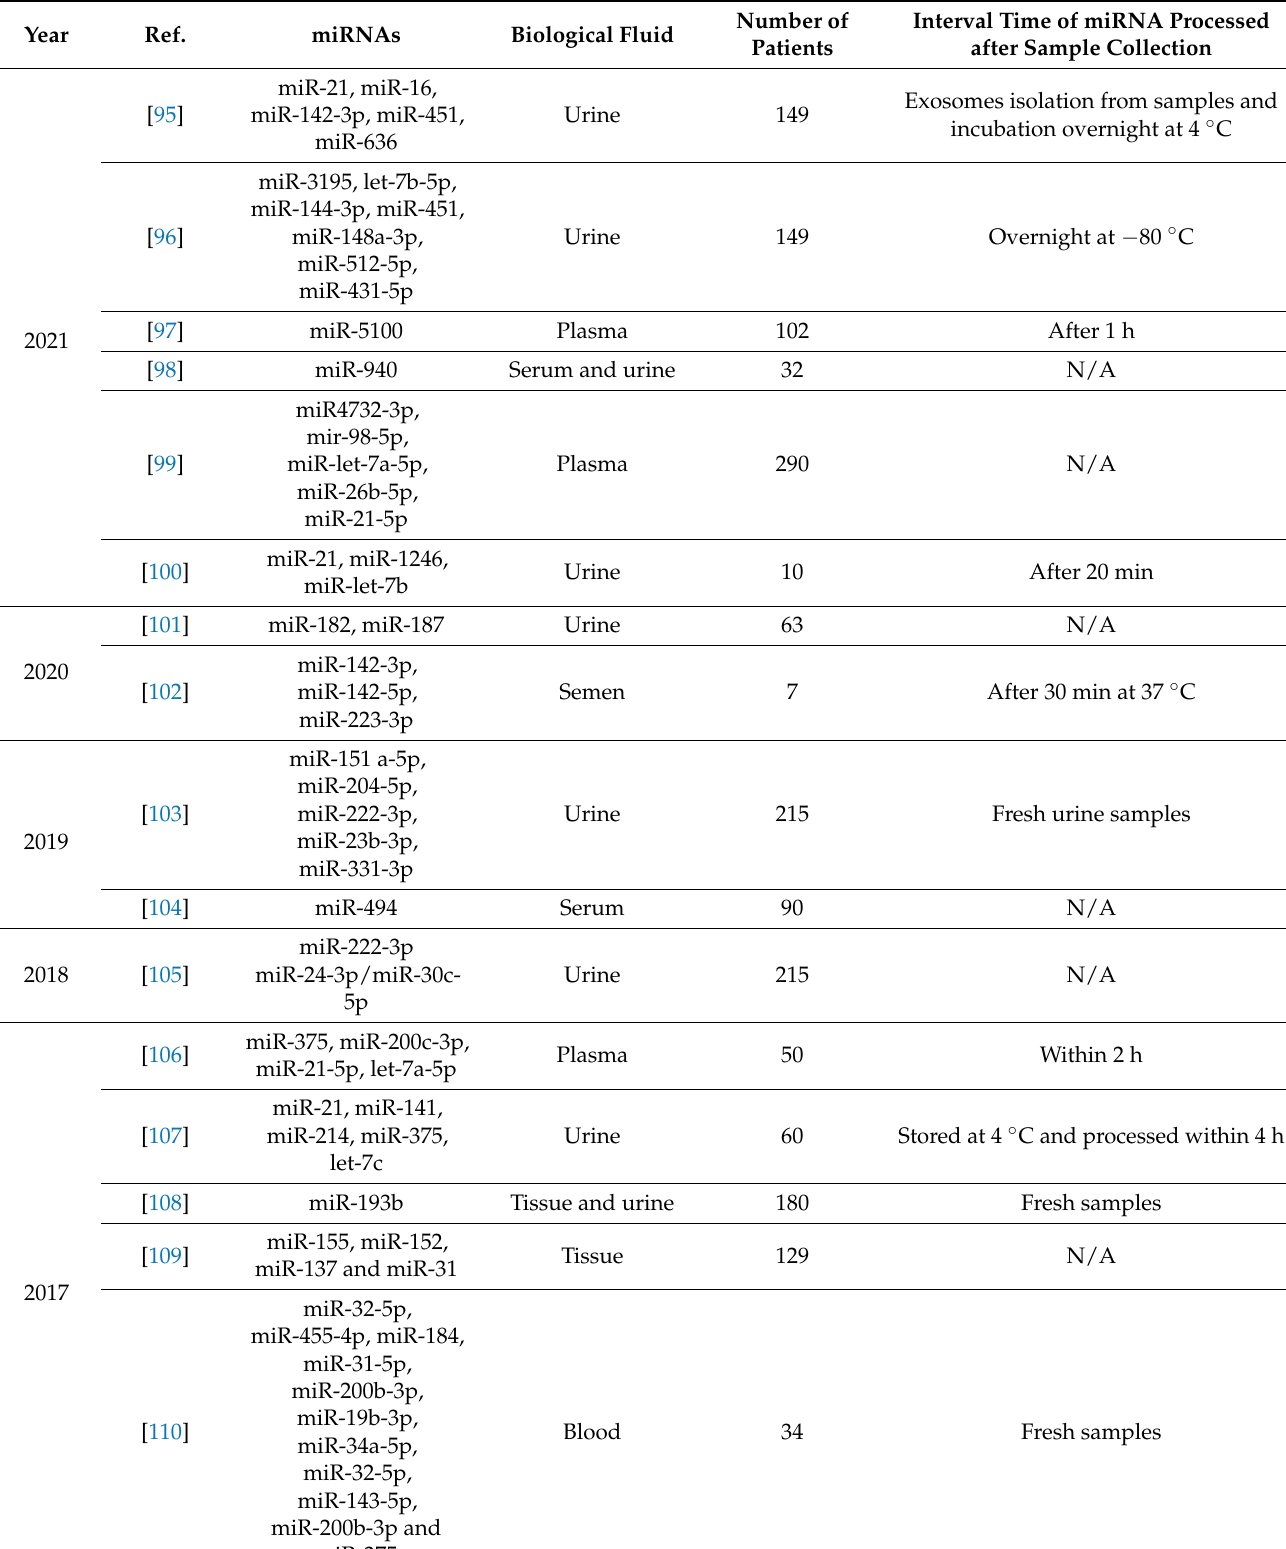
Table 3. List of the most relevant and representative papers clustered in topic 1 over the time. N/A: Not